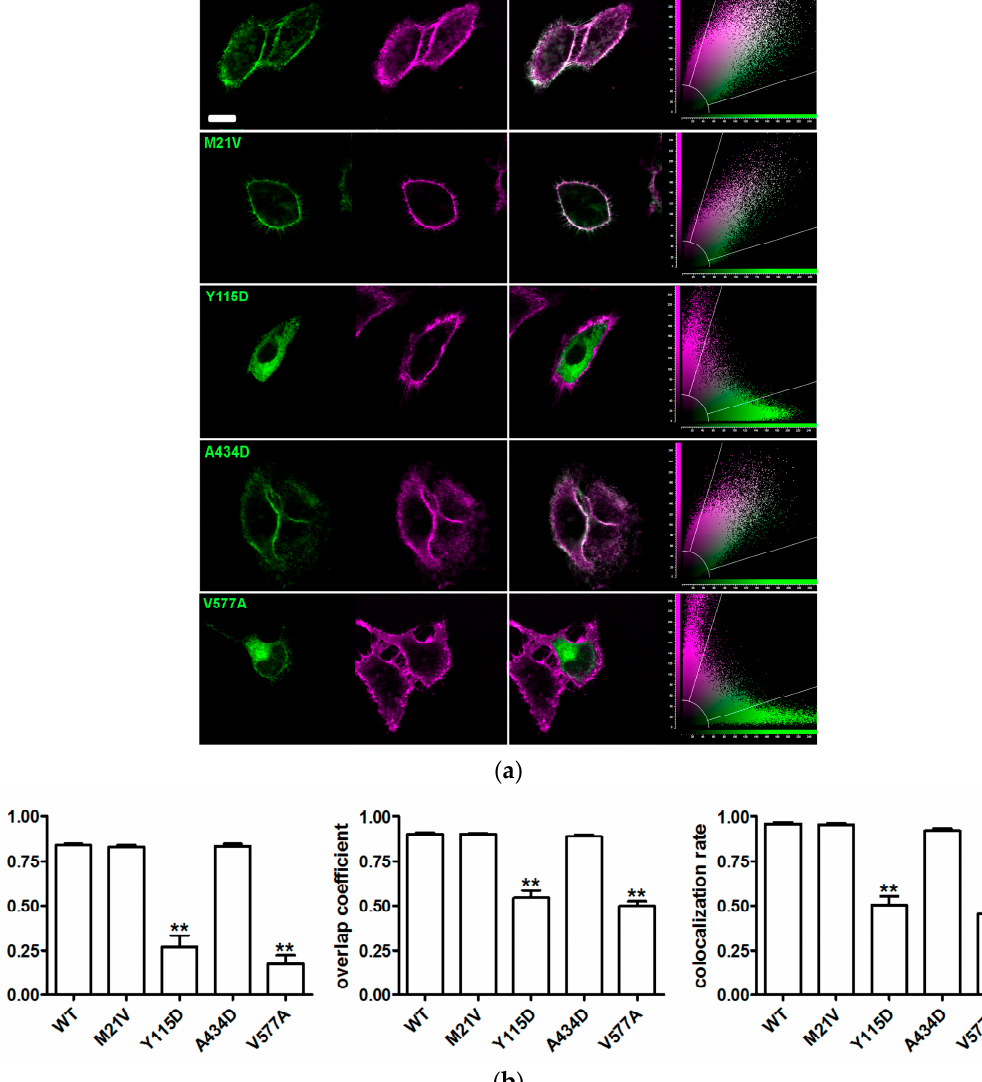
Figure 2. Co-localization of wild type pendrin and its variants with the plasma membrane. ( a ) From left to right: fluorescent signal of EYFP (green) fused to the C-terminus of the indicated pendrin variants and plasma membrane (magenta) of living HeLa cells 72 h after transfection, corresponding merge image and scatter plot. Scale bar: 12 µm; ( b ) Pearson’s correlation coefficient, overlap coefficient and co-localization rate referred to the co-localization of wild type (WT) pendrin and the indicated variants with the plasma membrane. Error bars represent SEM. ** p < 0.01 compared to wild type and therefore excluded from the plasma membrane, n = 12, one-way ANOVA with Dunnet’s multiple comparison post-test. ( n ) refers to the number of cells from 3 independent experiments.